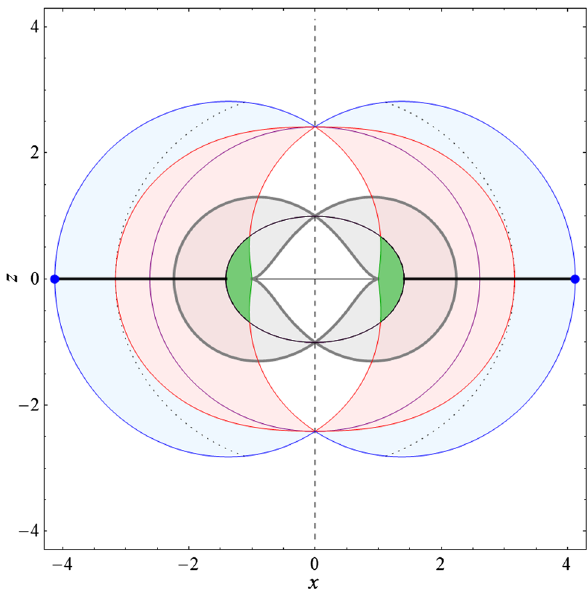
Fig. 16 Structure of the SPOs in the extreme Kerr BH a = 1